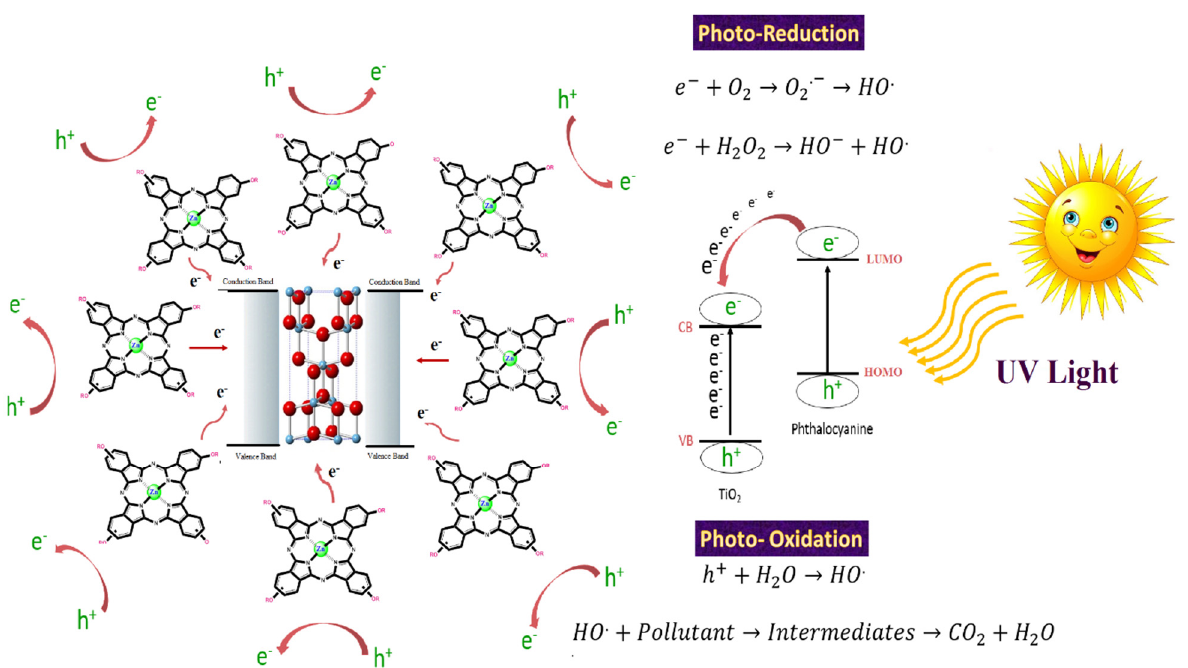
Figure 1. Schematic illustration of sensitization of TiO 2 with MPc.